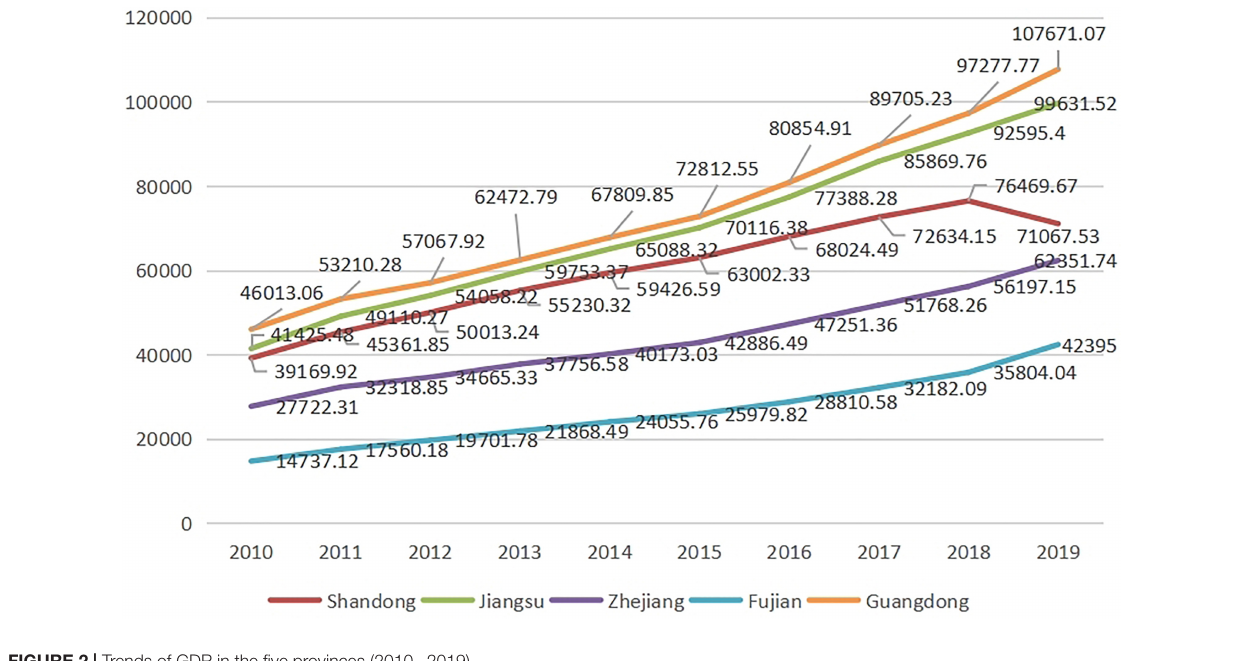
was the lowest (1.14%). As to secondary industry, the proportion in Jiangsu was the highest (29.40%), while that of Fujian was the lowest (19.89%). As to tertiary industry, the proportion in the lowest